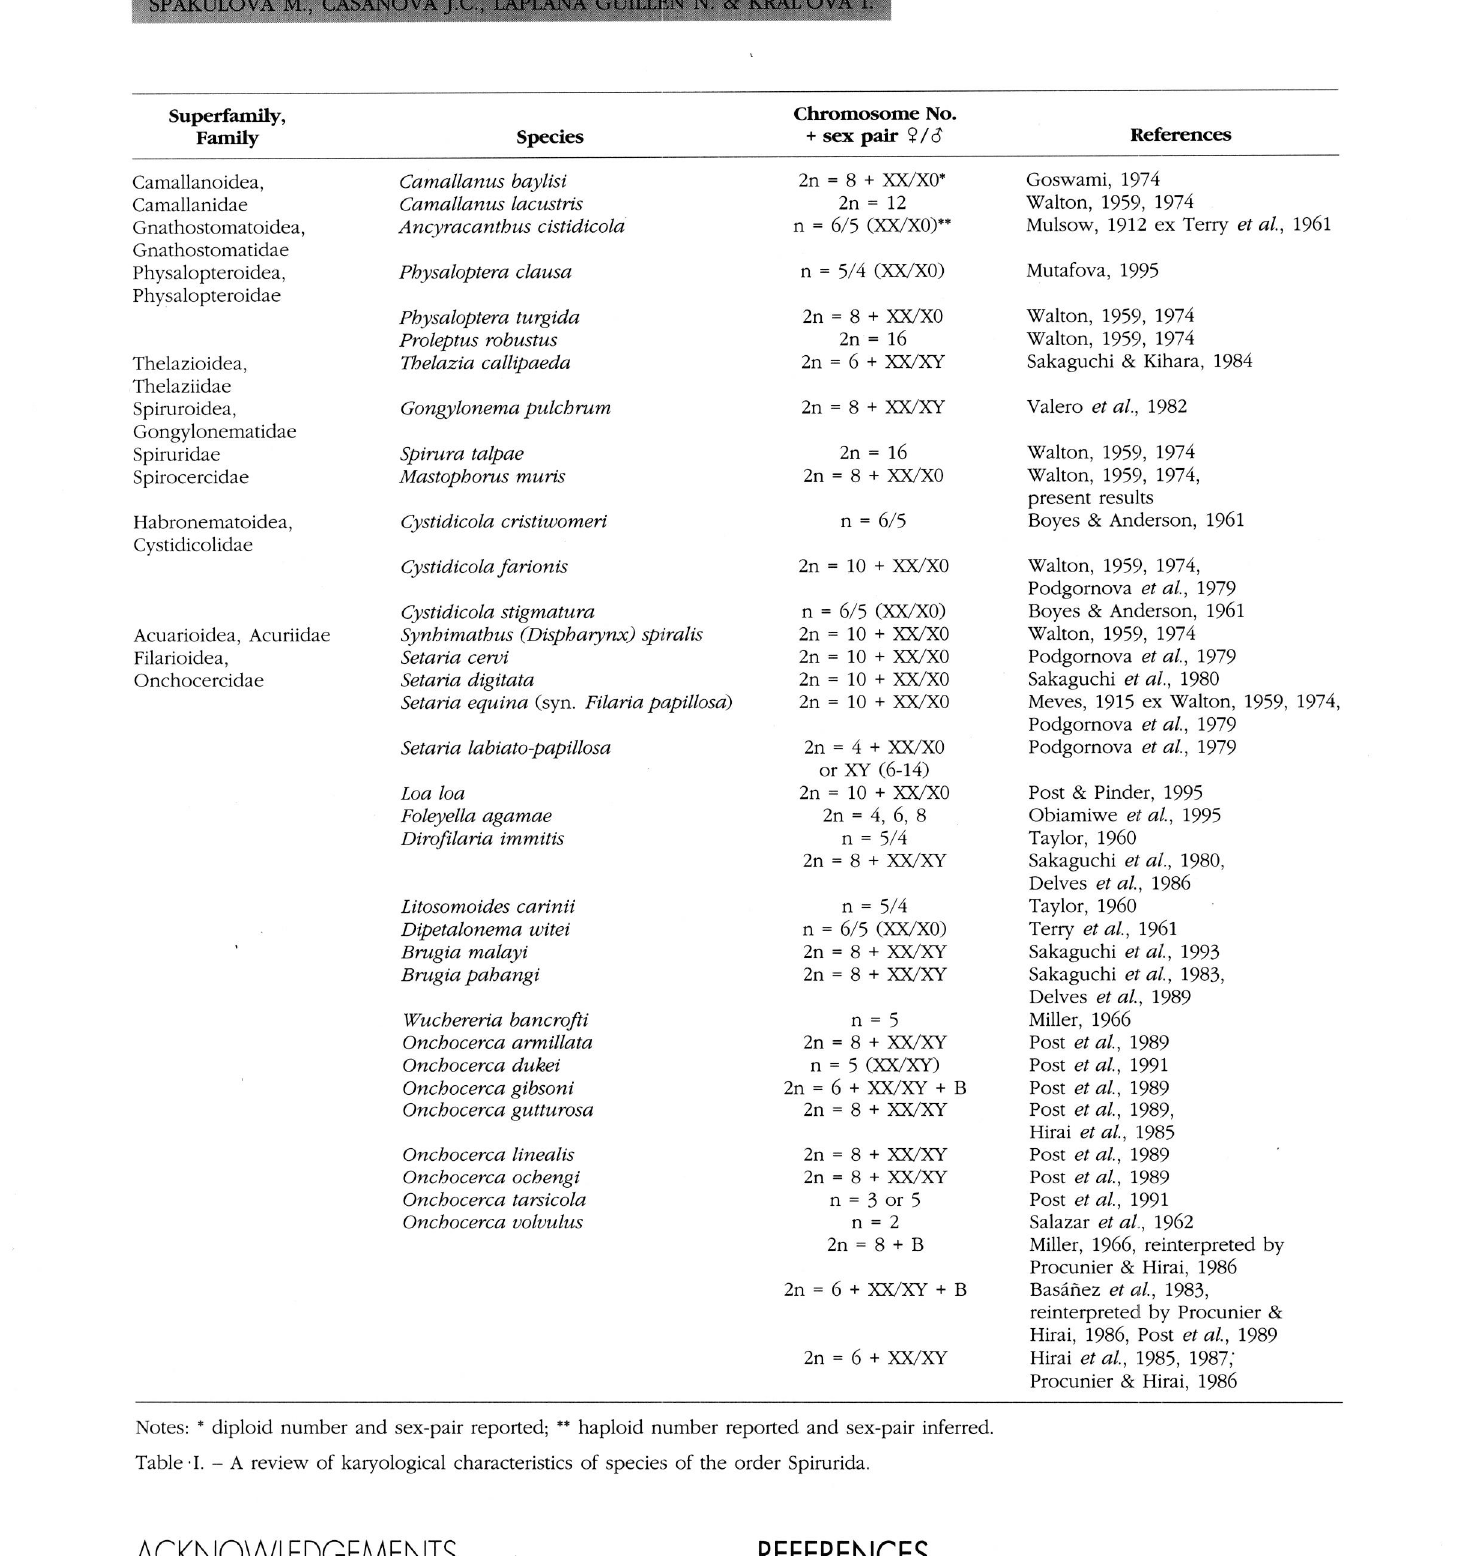
Tabled. - A review of karyological characteristics of species of the order